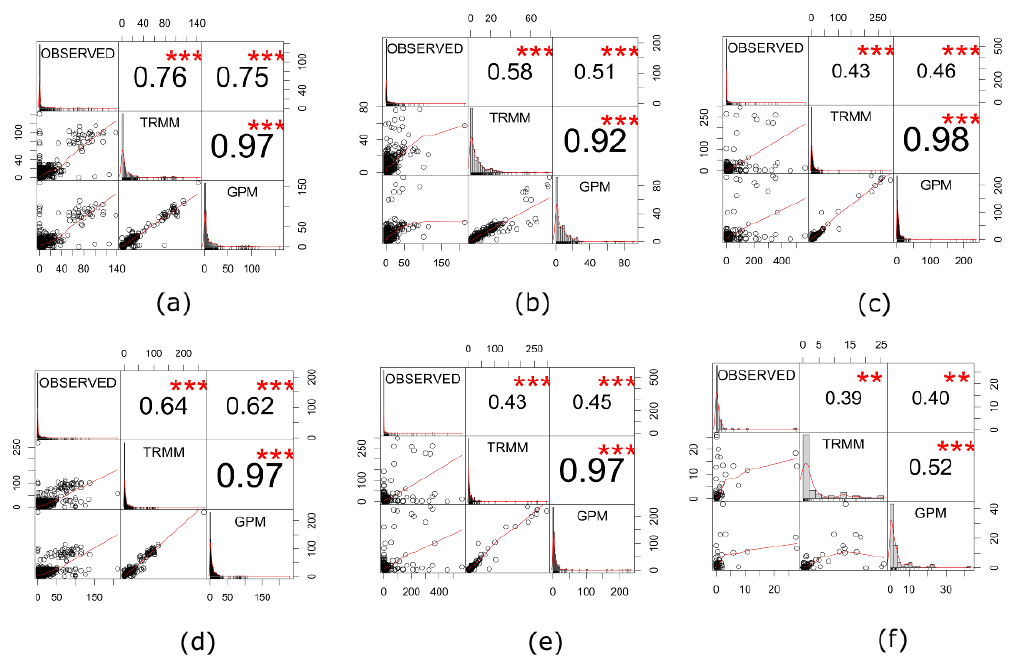
Figure 9. Scatterplot matrix showing the histograms, kernel density overlays, absolute correlation and significance levels (*** p < 0.001) between OBSERVED, TRMM, and GPM precipitation estimates for the year ( a ) 2016, ( b ) 2017, and ( c ) 2018 and region ( d ) Northern, ( e ) Dhofar, and ( f ) Interior.